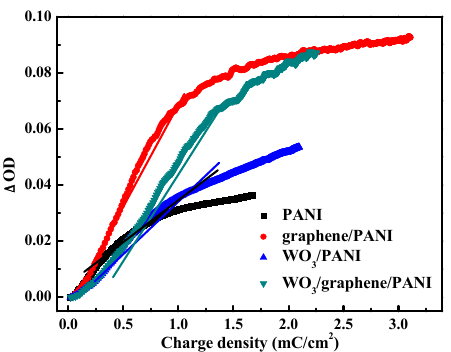
Figure 6. The plots of in situ optical density ( Δ OD) versus charge density of pristine PANI film, graphene/PANI film, WO 3 /PANI film, and WO 3 /graphene/PANI films. The optical density was measured at 633 nm at 0.8 V in 0.5 M H 2 SO 4 aqueous solution.